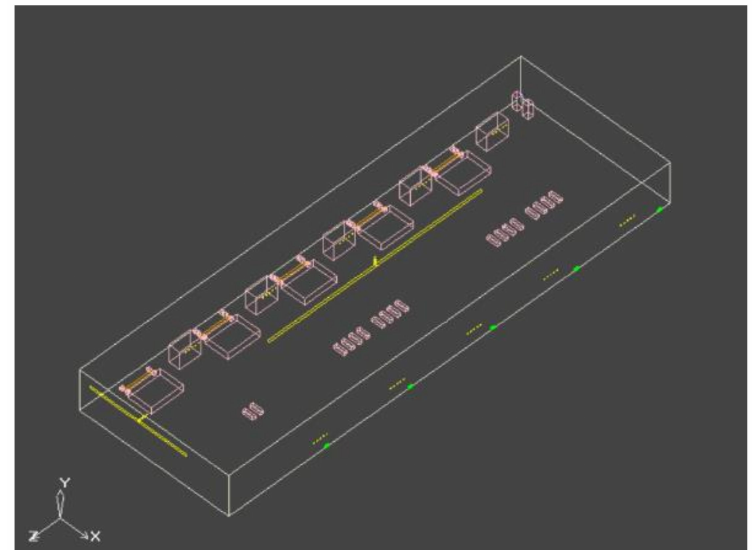
Figure 5. Working Condition 4 layout of natural vents.